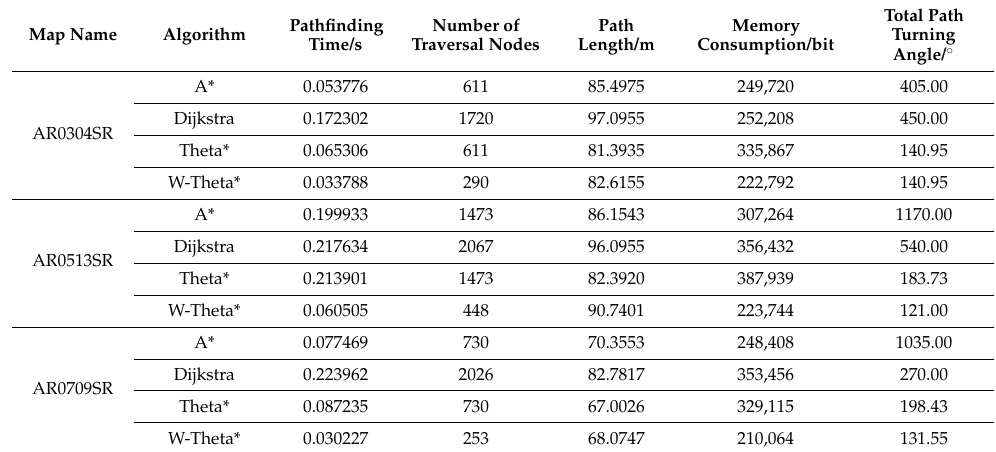
Table 3. Experimental data sheet for various algorithms on Baldurs Gate II map.